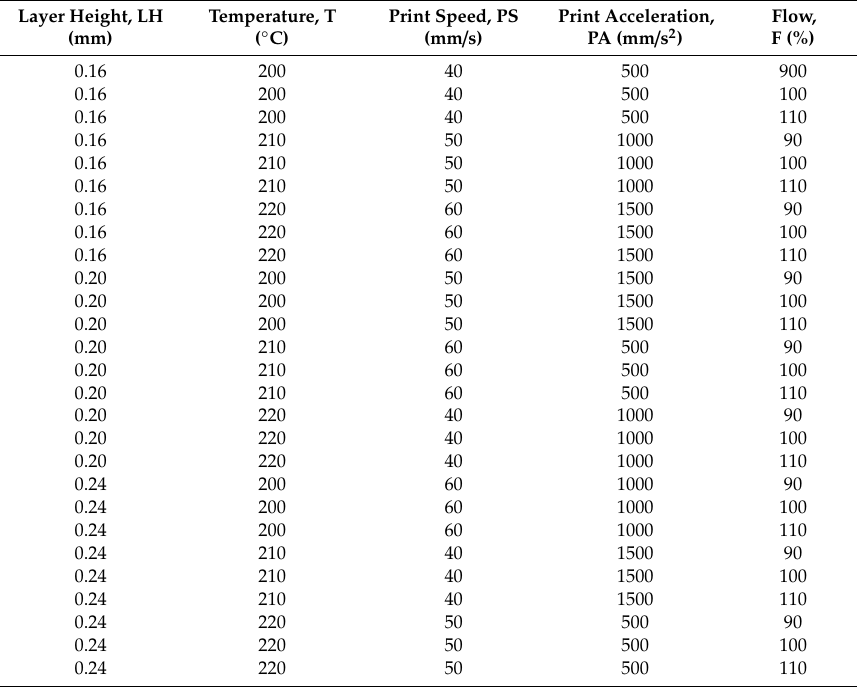
Table 3. Design of experiment L27 used in the present